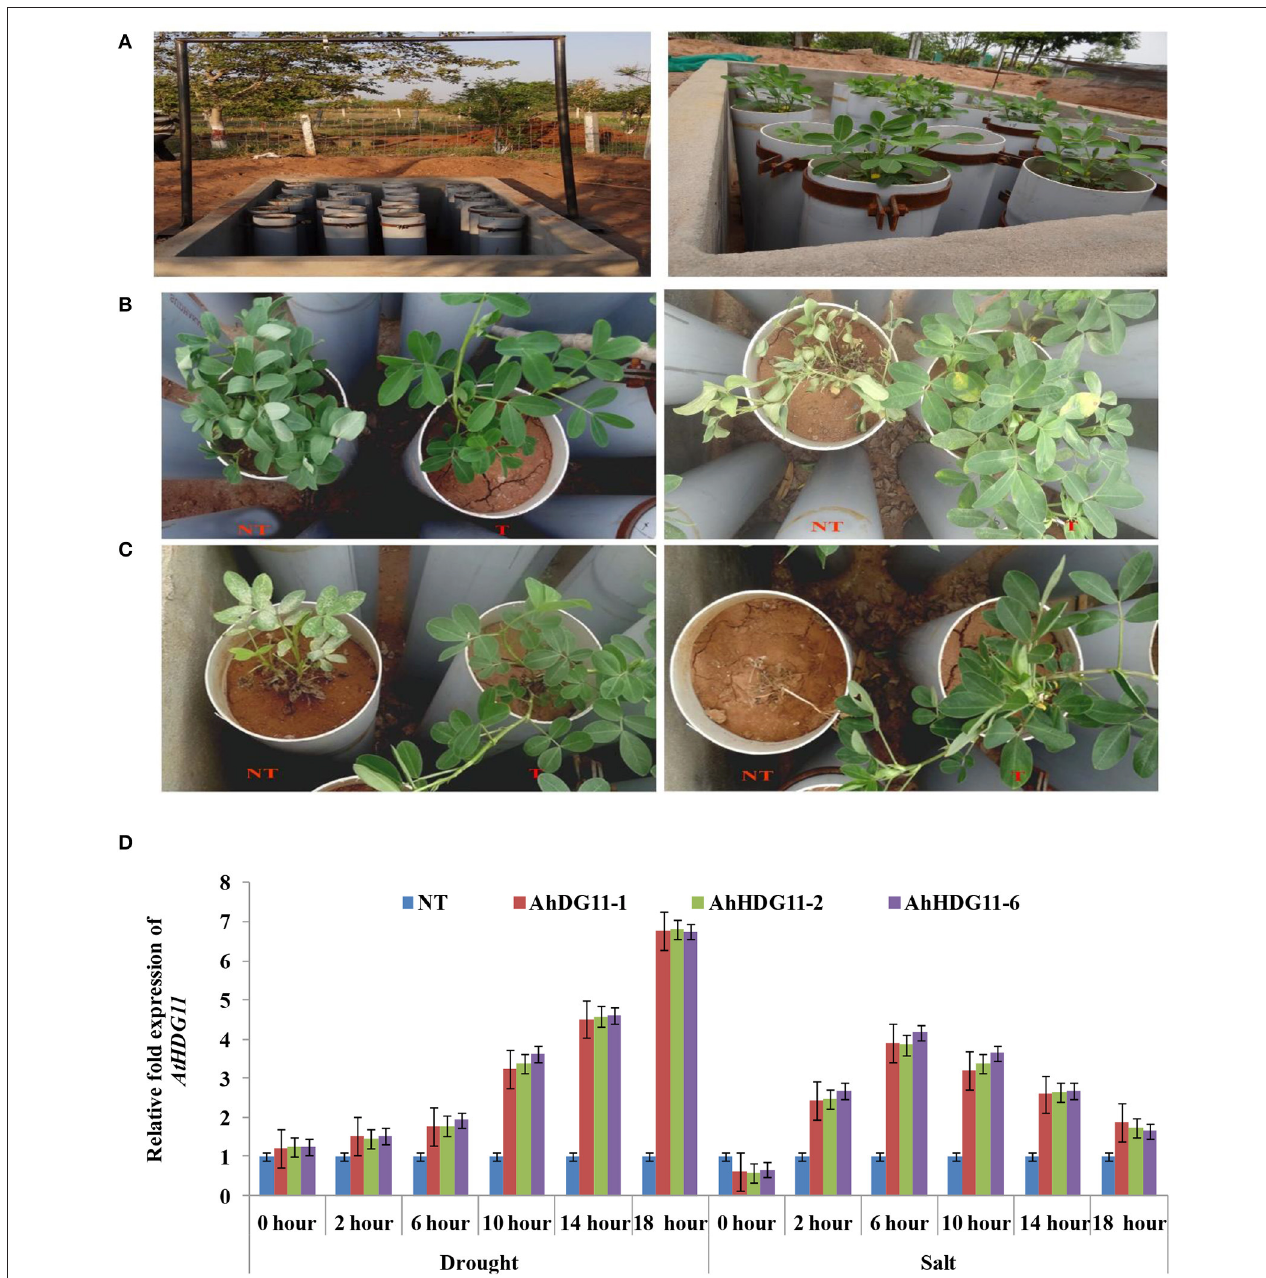
FIGURE 1 | Screening of non-transgenic and transgenic plants for drought and salt tolerance using lysimetric experiment. (A) Lysimetric experiment setup. Representative pictures of stress-induced phenotype of non-transgenic (NT) and transgenic (T) lines under (B) drought stress,15 days of stress imposition (left panel) and 30 days of stress imposition (right panel) (C) salt stress, 7 days of stress imposition (left panel) and 15 days of stress imposition (right panel). (D) qRT-PCR analysis of the T 3 generation peanut transgenic lines for the AtHDG11 transcript at various time points under induced drought and salt lysimetric experiments to check the stress-inducible expression of transgene AtHDG11 under rd29A promoter.